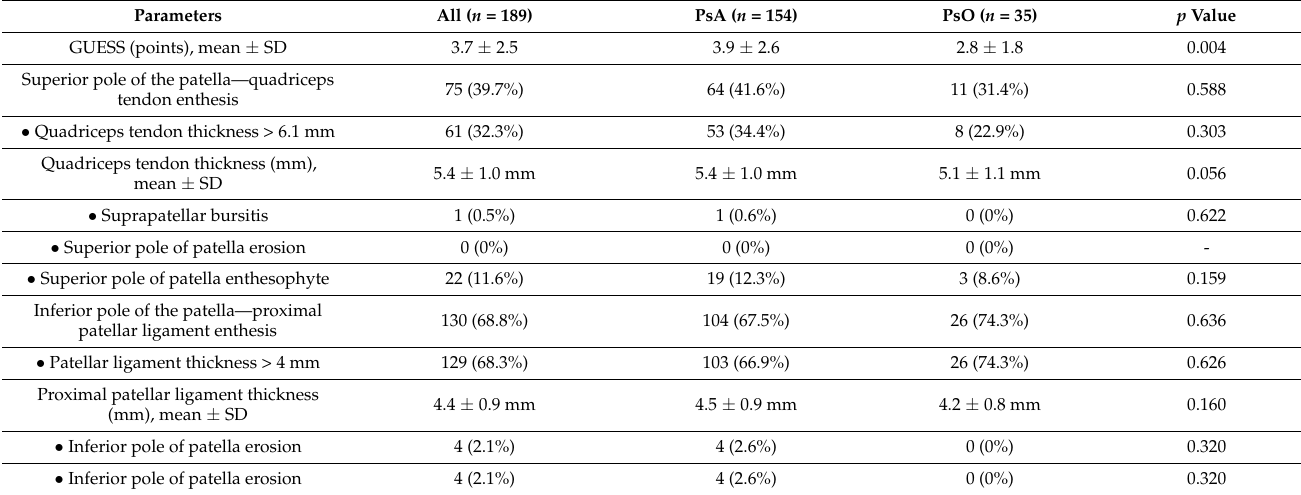
Table 3. GUESS values and tendon thickness of PsA and PsO